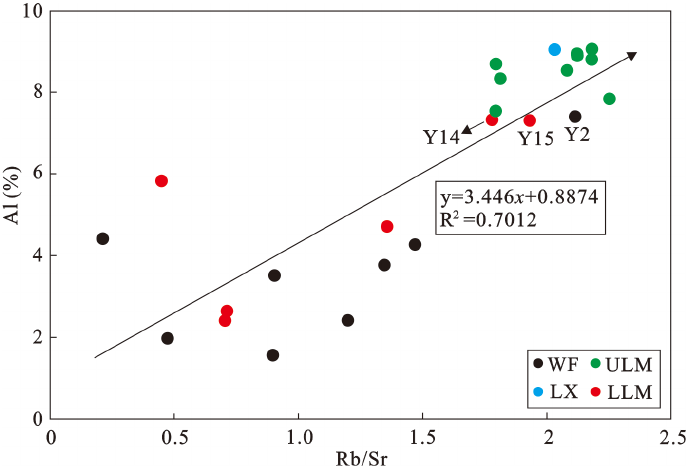
Figure 9. Crossplots of terrigenous influx proxy Al vs. palaeoclimate proxy Rb/Sr show that higher terrigenous influx is closely associated with the warmer and wetter palaeoclimate in the LX, lower WF (sample Y2), upper LLM (samples Y14 and Y15), and ULM.